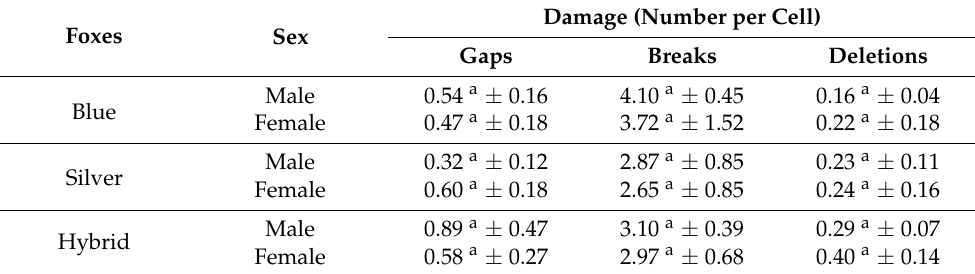
Table 3. Number of FS—types of damage. Damage (Number per Cell) Foxes Gaps Breaks Deletions Blue 0.51 ab ± 0.17 3.9 1 a ± 1.09 Silver